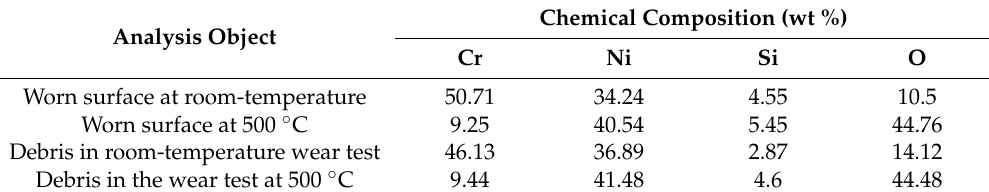
Table 2. EDS results of the worn surface and the wear debris of the Cr 13 Ni 5 Si 2 coating.